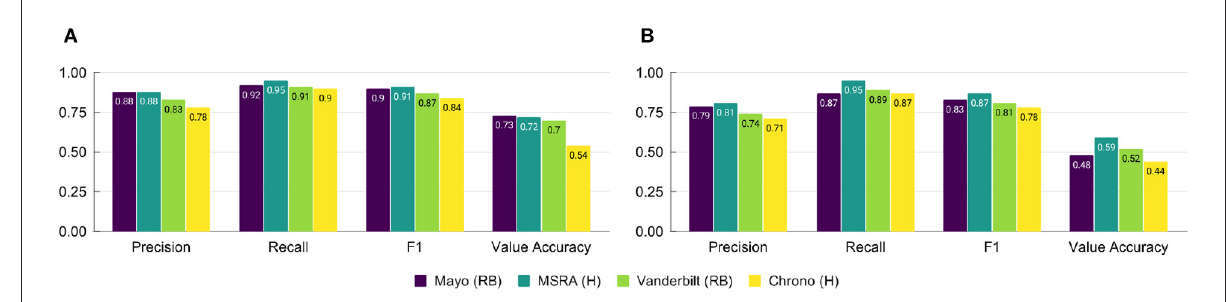
FIGURE3 Performance of top systems from the 2012 i2b2 Temporal Challenge and Chrono on (A) the full evaluation data set, and (B) the subset of poor performing files using span-based P, R, and F1 metrics. RB, Rule-Based; H, Hybrid.